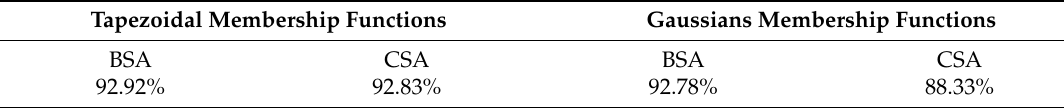
Table 11. Comparison of BSA and CSA